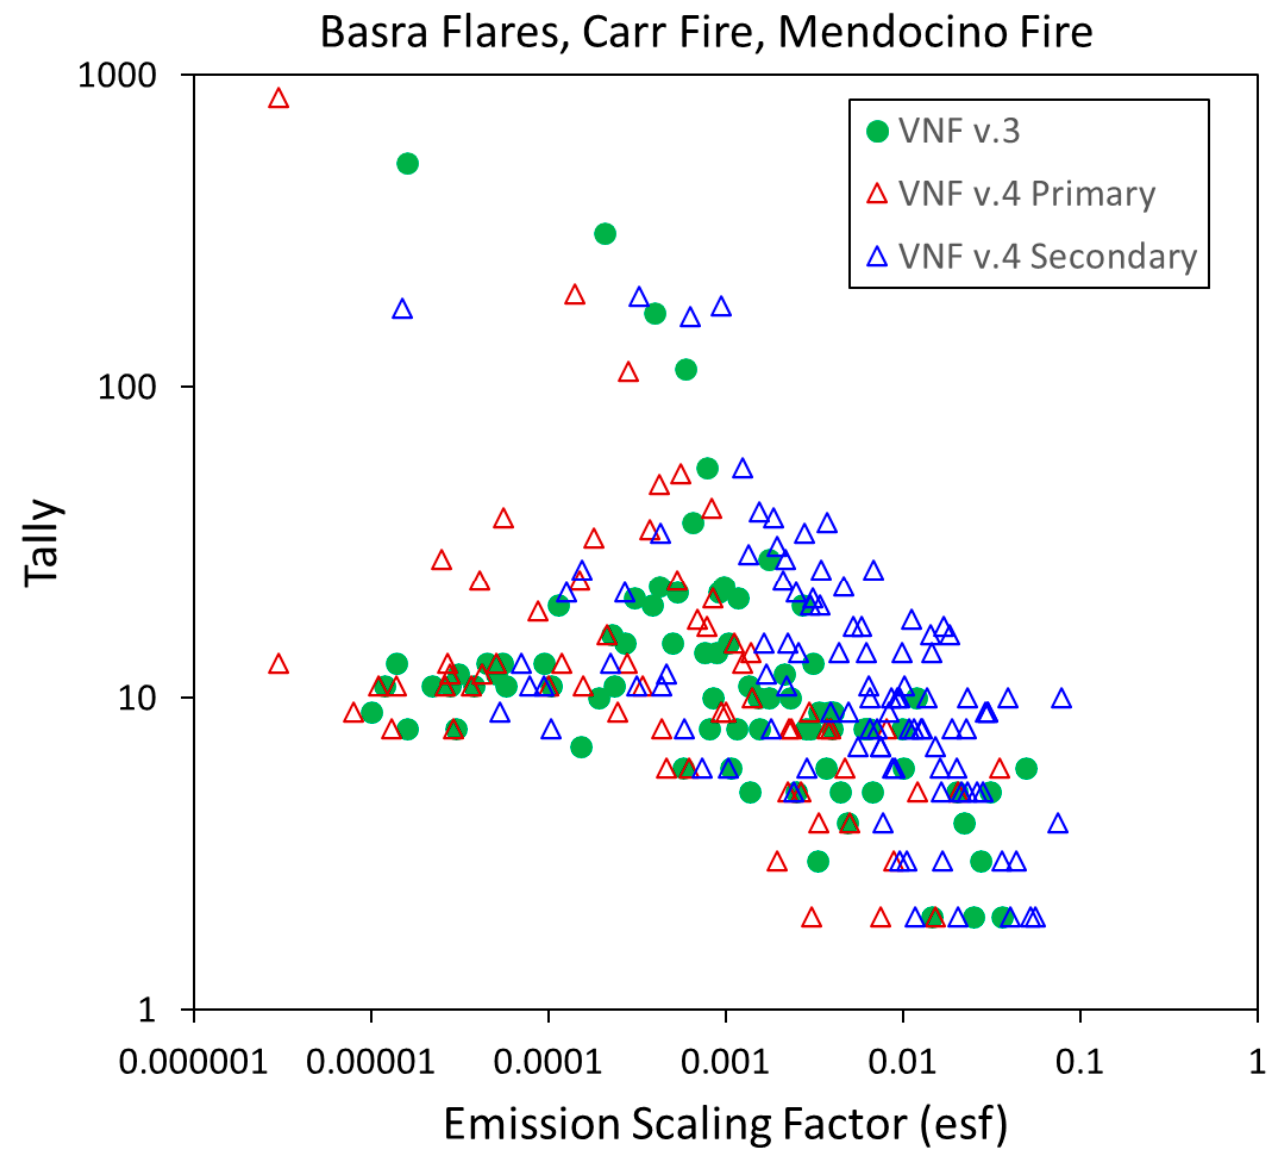
Figure 22. Emission scaling factors for the test cases studied in this paper. None of the pixels had esf values over 0.1, which corresponds to 10% of the pixel’s surface area.